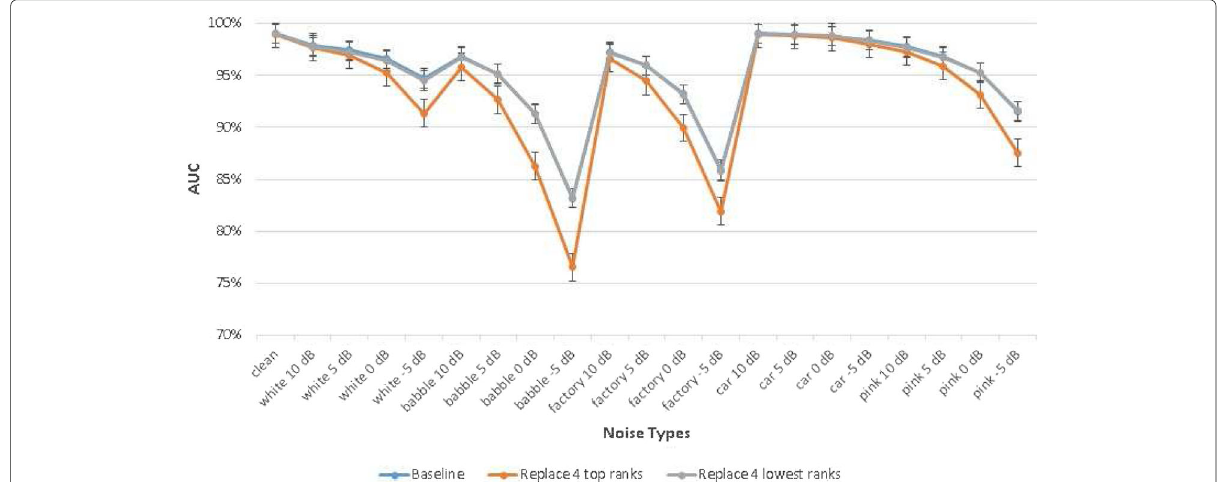
Fig. 11 VAD performance of the proposed method after replacing the subband values of top 4 ranks and the lowest 4 ranks with